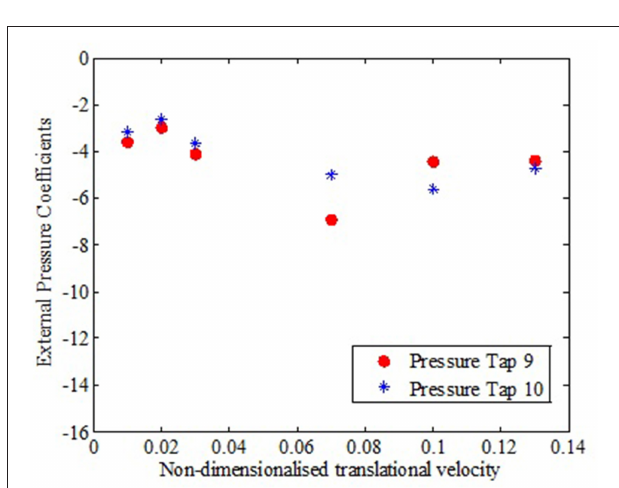
FIGURE 11 | External pressure coefficients at different locations of side wall to translating vortex at various translational velocities.